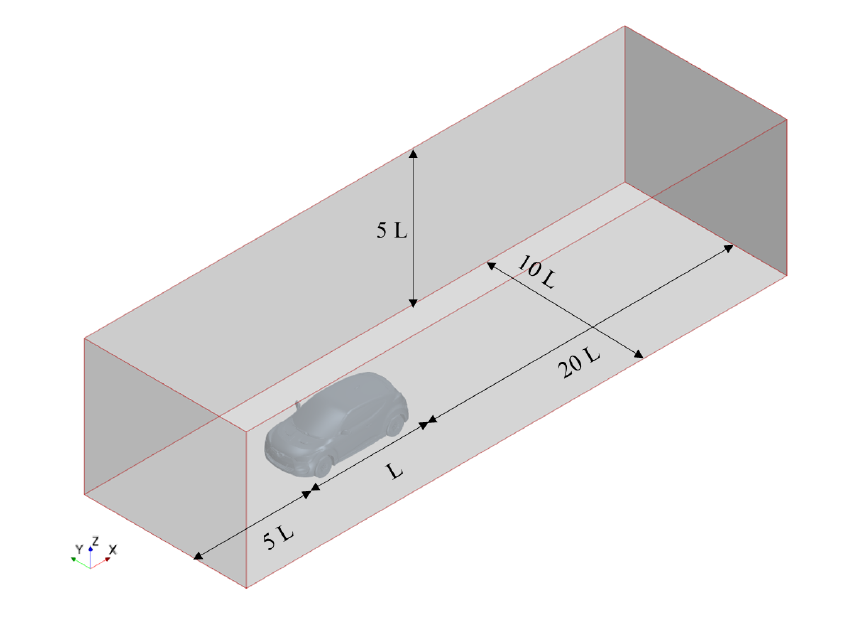
Figure 4. The computational